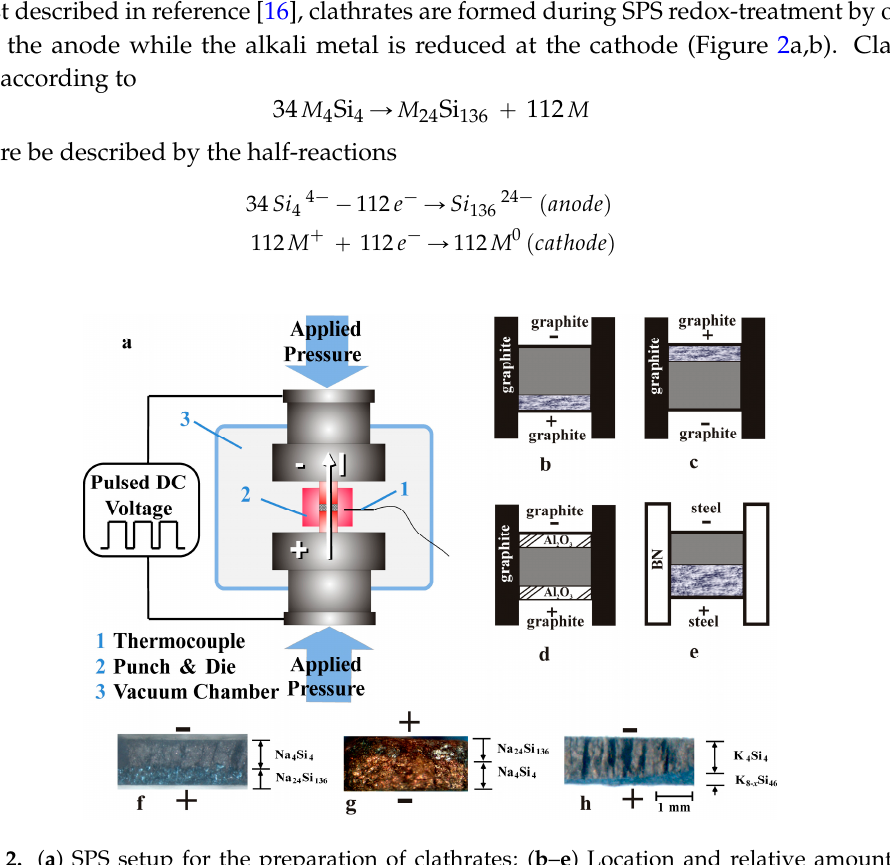
Figure 2. ( a ) SPS setup for the preparation of clathrates; ( b – e ) Location and relative amounts of the reaction products for different polarities and different die and punch materials; ( f – h ) Optical micrographs of the cross-sections from fractured post-reaction pellets illustrating the directional growth of clathrates at the anode.